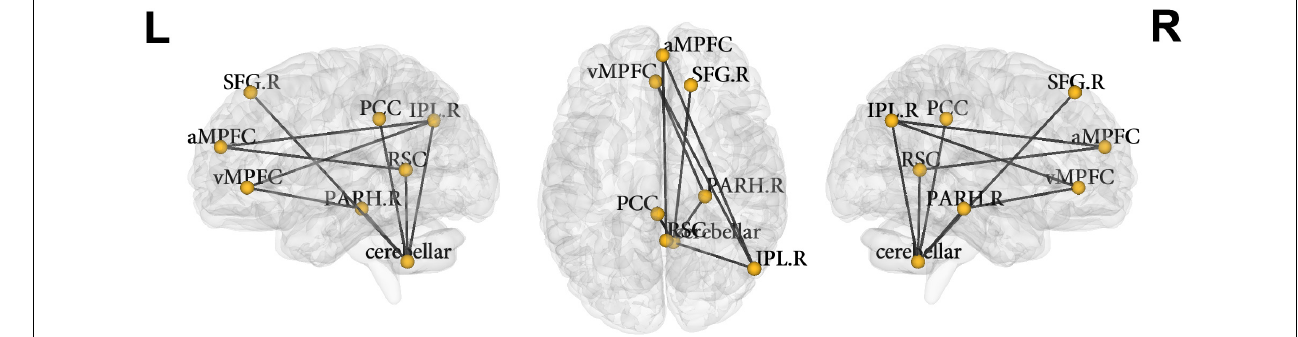
FIGURE 2 | Nodes of the default mode network identified to be significantly different between ADHD-C and ADHD-I groups using NBS. vMPFC, ventral medial prefrontal cortex; aMPFC, anterior medial prefrontal cortex; PCC, posterior cingulate cortex; IPL.R, inferior lateral parietal (right); SFG.R, superior frontal gyrus (right); PARH.R, parahippocampus (right); cerebellar, cerebellar tonsils; RSC, retrosplenial cortex; L, left; R,